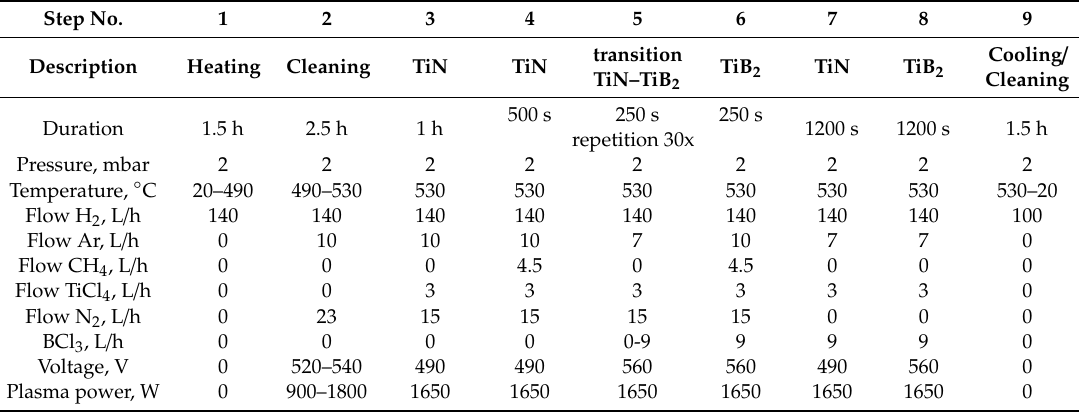
Figure 5. Scheme of plasma-assisted chemical vapor deposition (PACVD) coating. Table 3. The characteristics of titanium boron nitride (TiBN) coating by PACVD